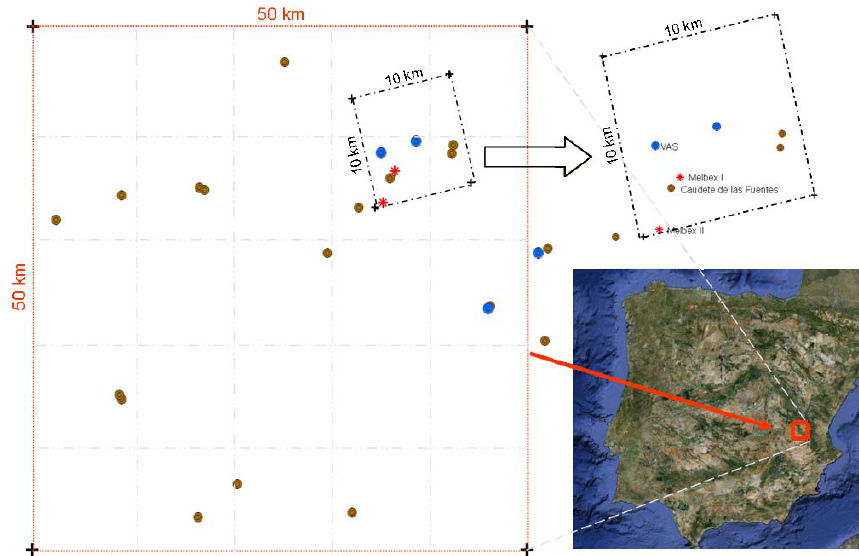
Fig. 1. Location and distribution of the meteorological stations over the 50 × 50km 2 VAS